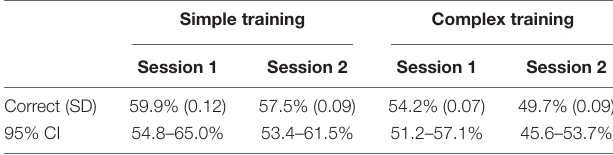
TABLE 4 | GJT accuracy performance by training condition across